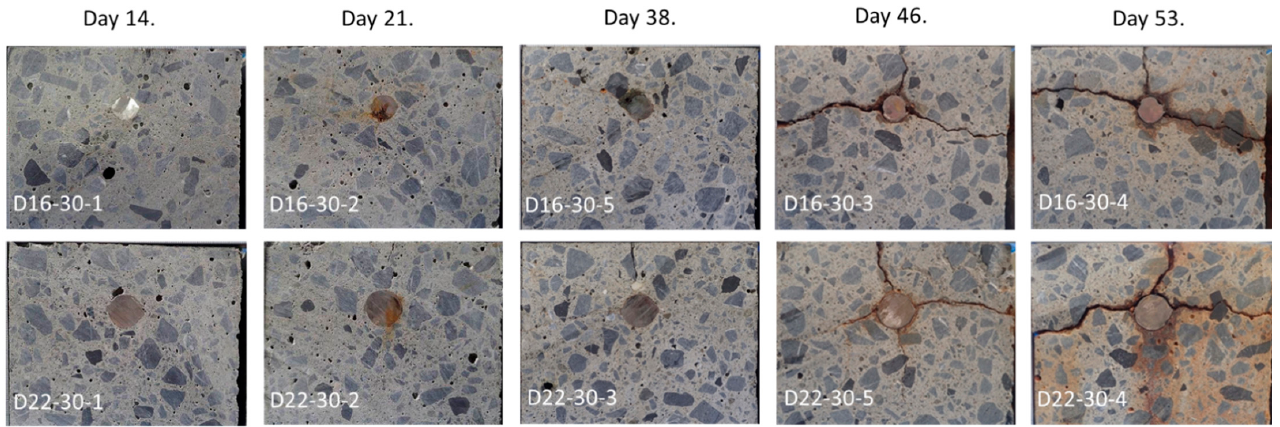
Figure 10. Cross-sectional photos of test pieces after terminating the electrolytic corrosion test.